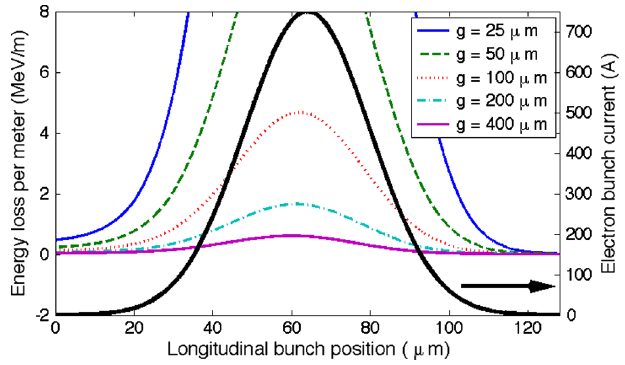
FIG. 18. Resistive wall component of the longitudinal wake- 100 pC Gaussian electron bunch between field for a 750 A peak two parallel aluminum plates separated by g .